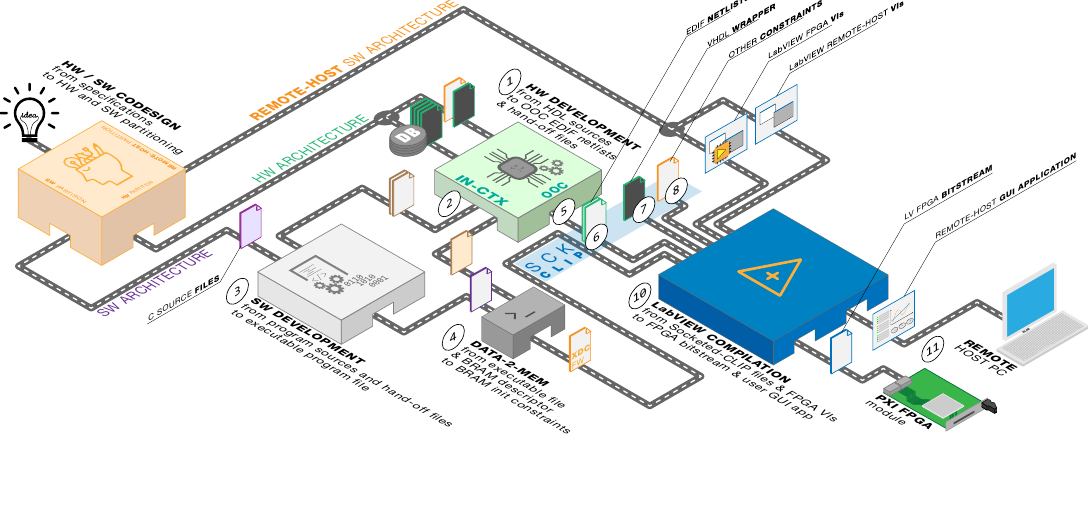
Figure 5. New design workflow exploiting the LVFPGA SckCLIP macro